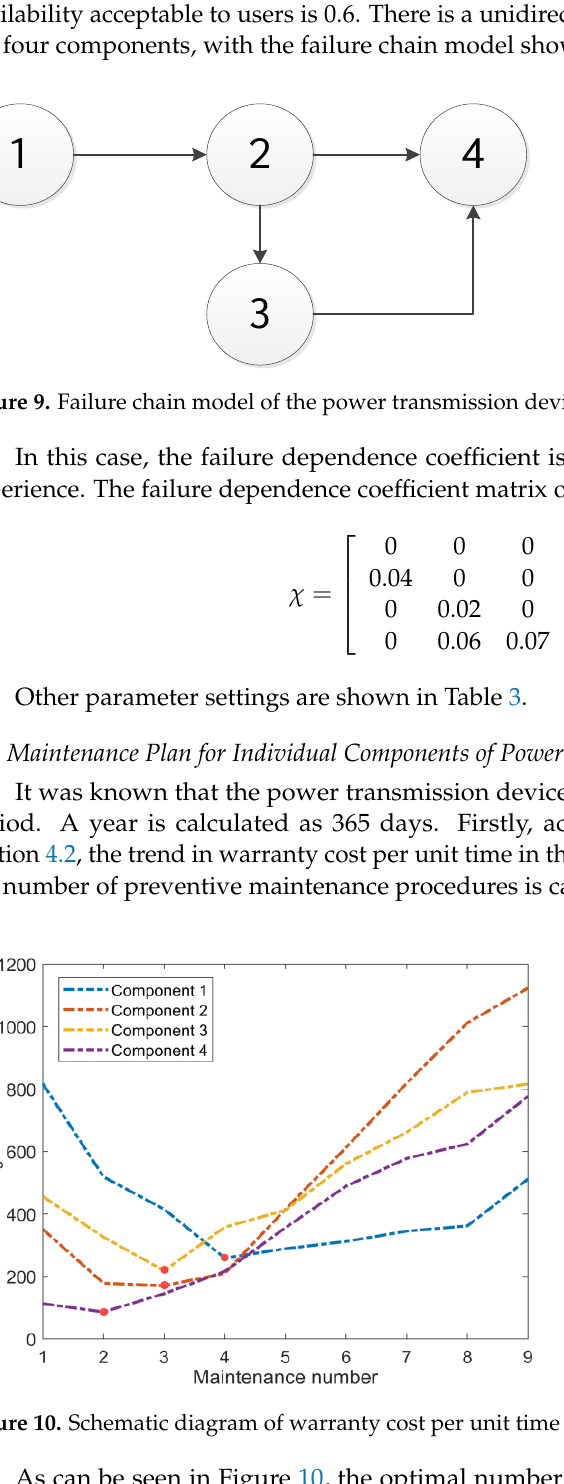
Figure 10. Schematic diagram of warranty cost per unit time changes of each component.